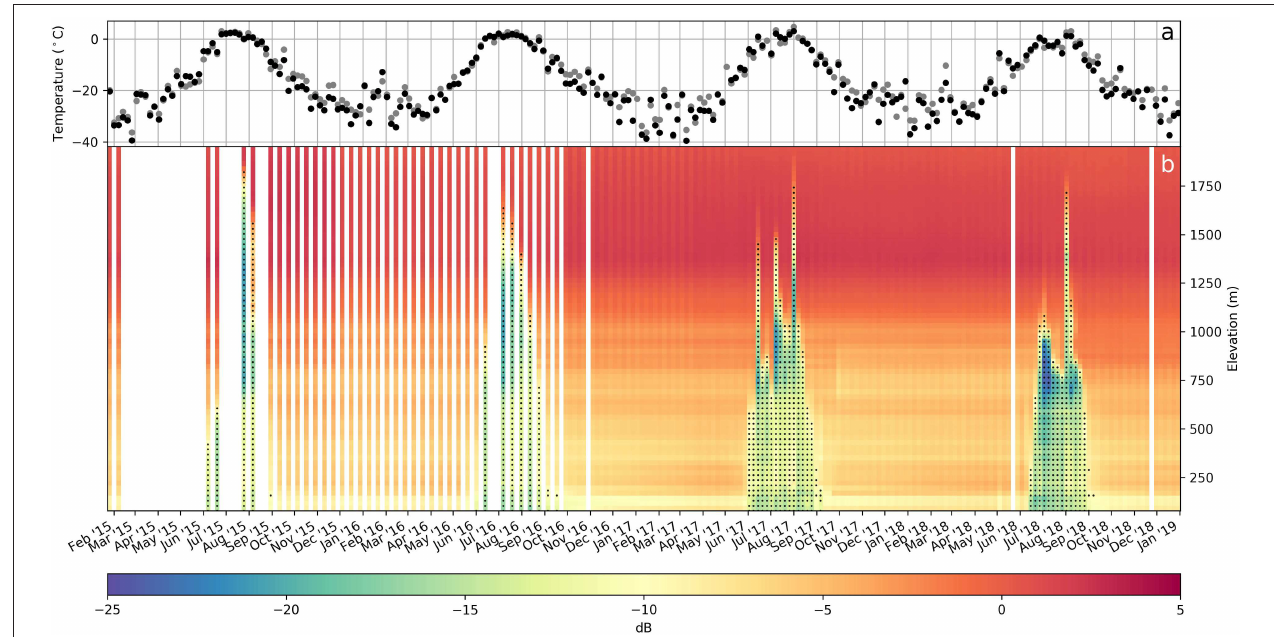
FIGURE 2 | Near surface air temperature measured at PROMICE AWS KPC_U (Fausto and van As, 2019, Figure 1 , black dots) and ERA5 2 m air temperature reanalysis estimates at the same location ( Hersbach and Dee, 2016, gray dots, (a) ). Heat plot of Sentinel-1 backscatter coefficient γ 0 time series (b) . Data are extracted from the hatched polygon shown in Figure 1 and binned to 25 m elevation classes. Bins with surface melt are marked by small black